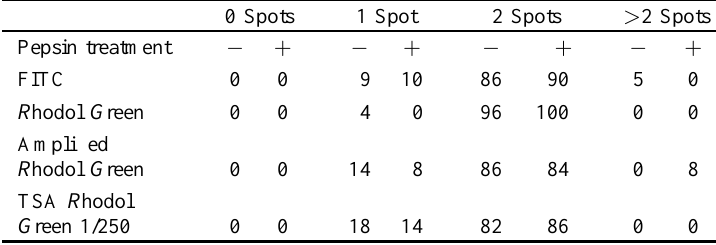
Table 1 Effect of pepsin treatment on manual scoring (30 nuclei)